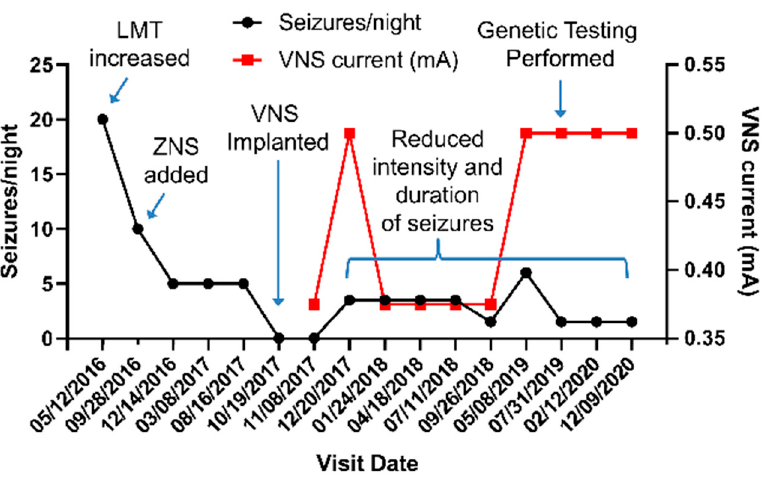
Figure 1. Patient Timeline . Seizure burden overall improved with increasing dose of lamotrigine (LMT), addition of zonisamide (ZNS), and titration of vagus nerve stimulator (VNS) settings.